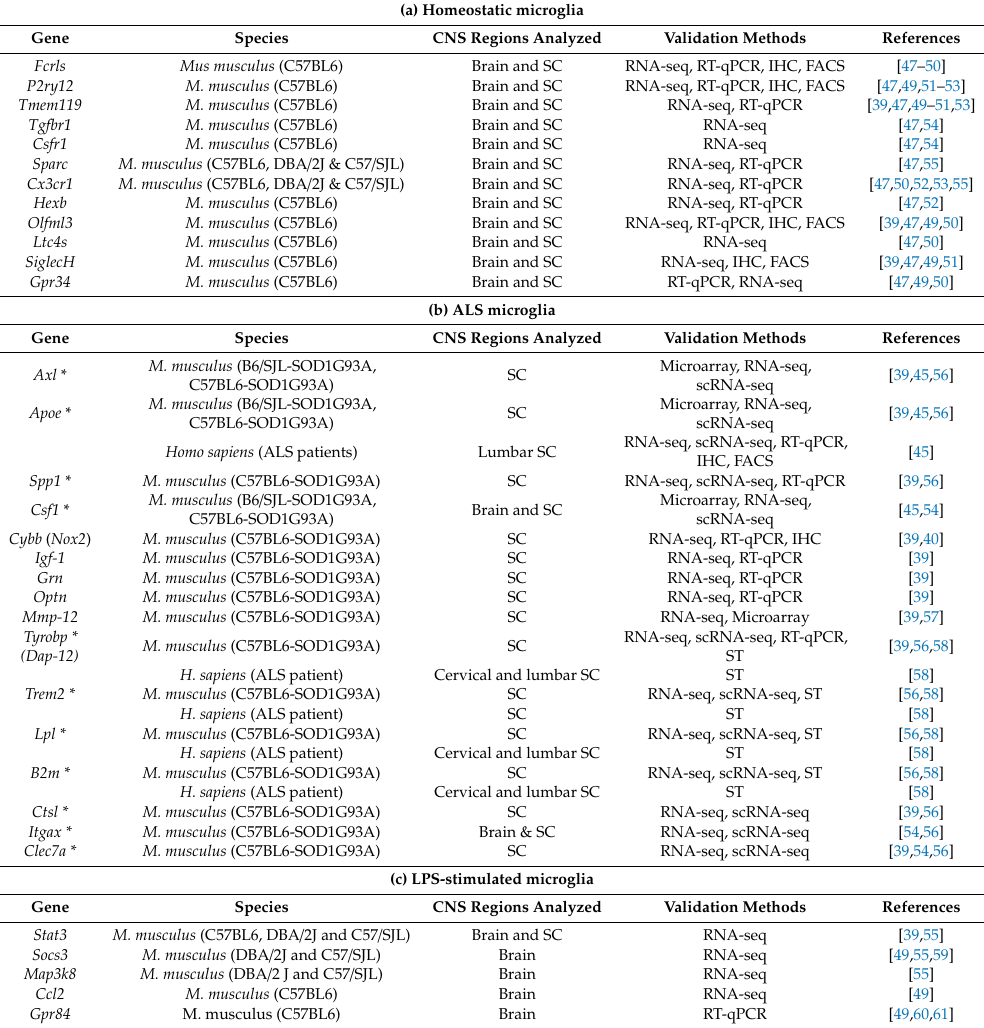
Table 1. ( a ) Gene-signature of homeostatic microglia; ( b ) gene signature of ALS microglia; ( c ) gene signature induced by LPS